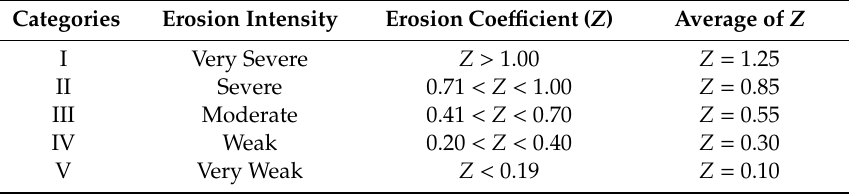
Table 2. The values of the Z coe ffi cients classified according to the degree of erosion intensity.